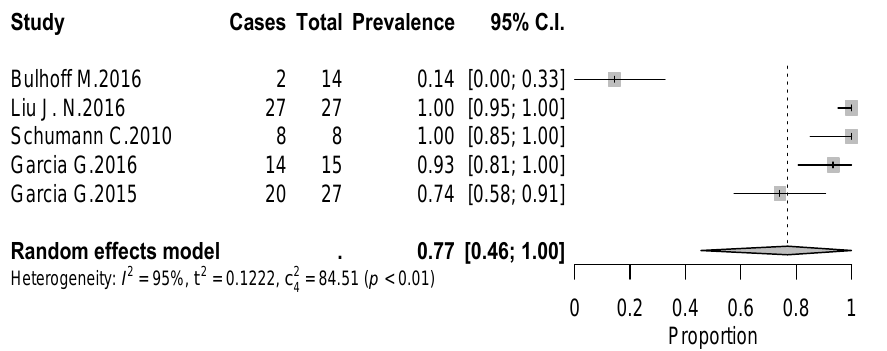
Figure 3. Forest plot chart of the rate of return to sports at the same or a higher level of play as before shoulder arthroplasty with 95% confidence interval.